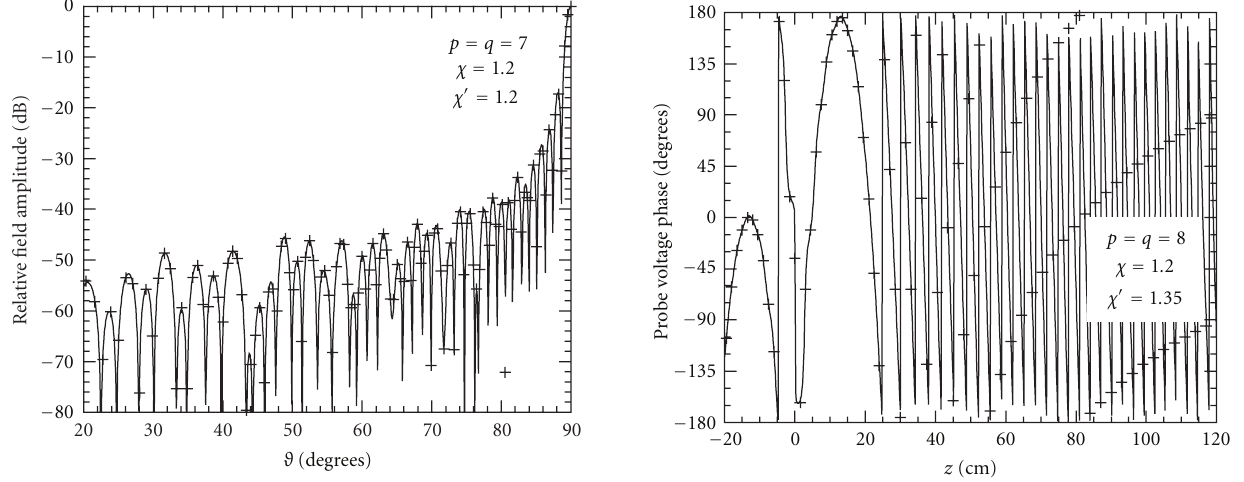
Figure 12: Phase of the probe output voltage V on the generatrix at ϕ = 0 ◦ . Solid line: measured. Crosses: